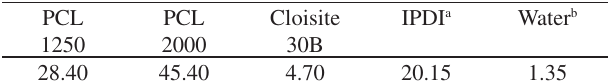
Table 1. Composition wt.(%) of the synthesized polyurethane nanocomposite.